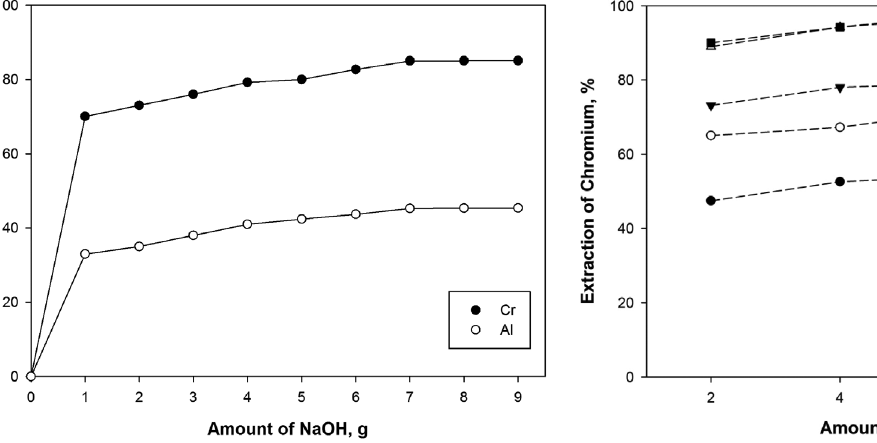
Fig. 4: Change in extraction (%) of Cr and Al with regard to the NaOH amount (1 g conc. 600 °C, 1 h)